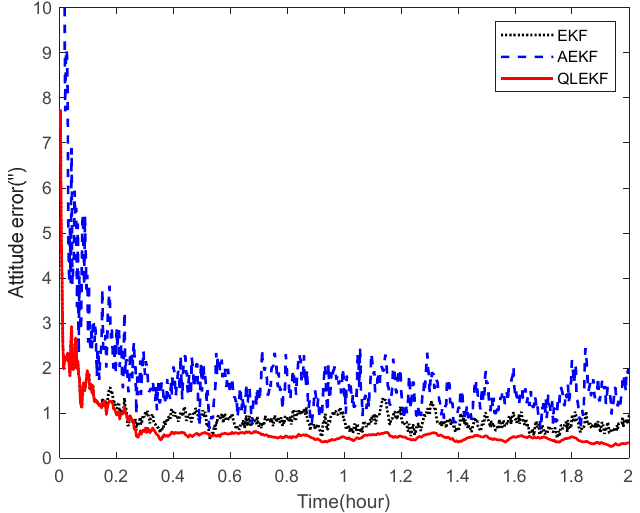
Figure 18. RMSE of the attitude estimation for EKF, AEKF and QLEKF. According to the simulation results, the EKF provides similar results to the AEKF, while the QLEKF outperforms both the EKF and the AEKF with higher precision on average. These results demonstrate that the Q-learning approach is valuable for fine-tuning the critical parameters of the navigation